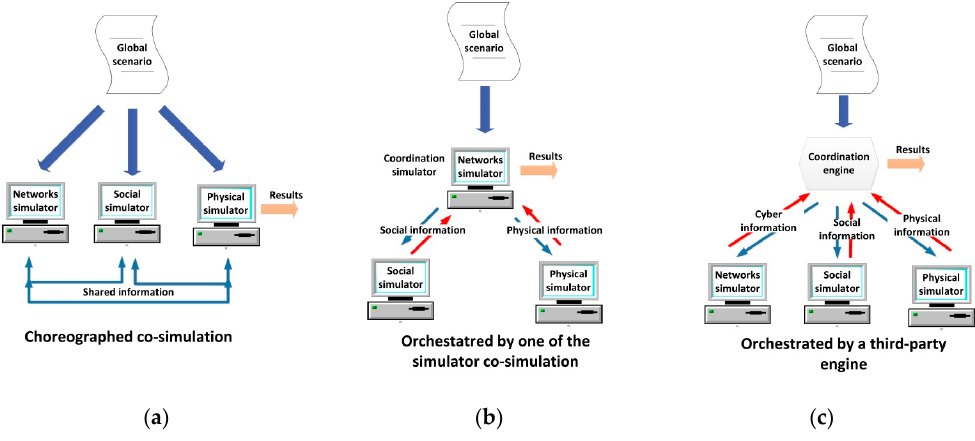
Figure 5. Different simulation paradigms ( a ) Choreographed ( b ) Orchestrated by one of the simulators ( c ) Orchestrated by a third-party engine.